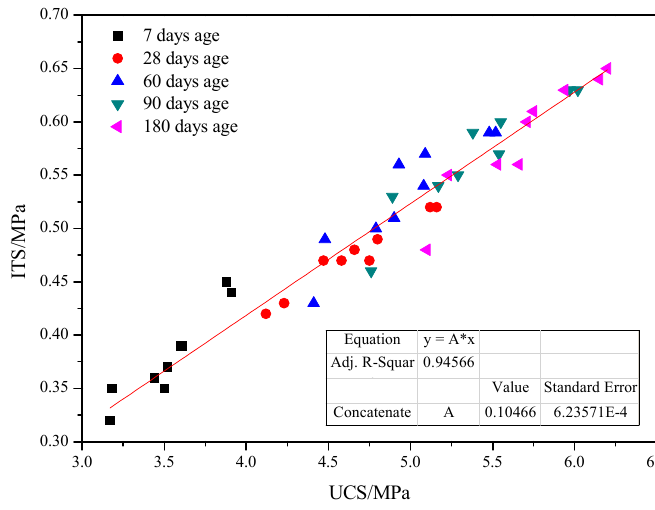
Figure 8. Relationship between the UCS and ITS.